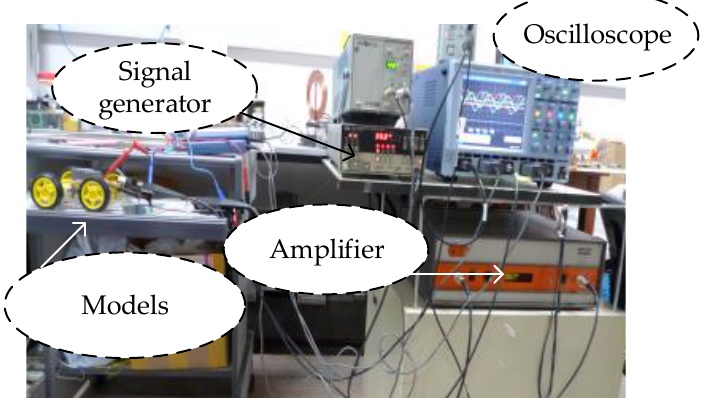
Figure 10. Testing bed of experimentation. Table 3. Specifications of coils for experimentation.